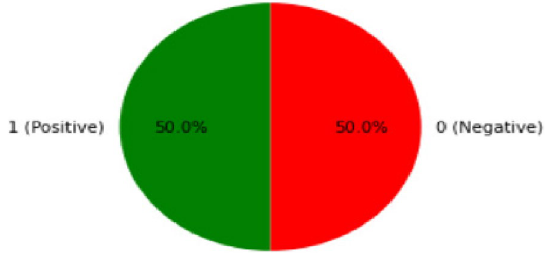
Fig. 2 IMDB dataset sentiment class distribution